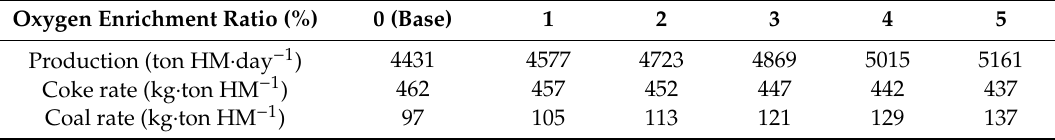
Table 4. Typical parameters when the oxygen enrichment ratio